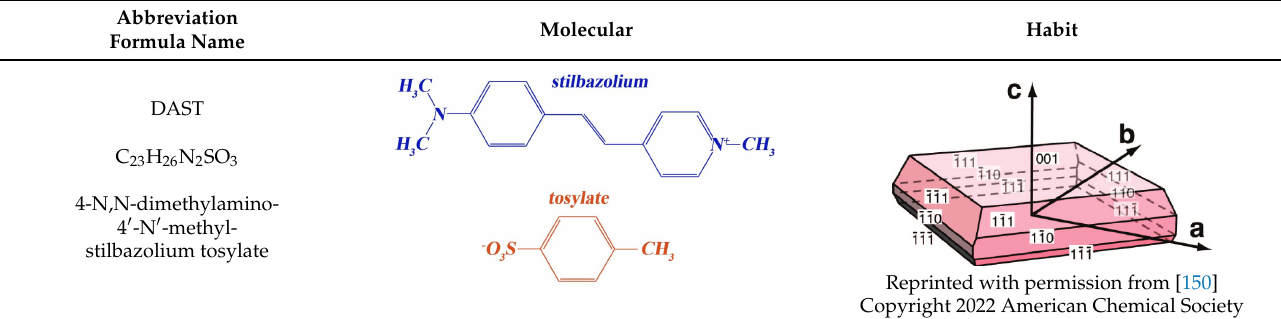
Table 2. Crystals under